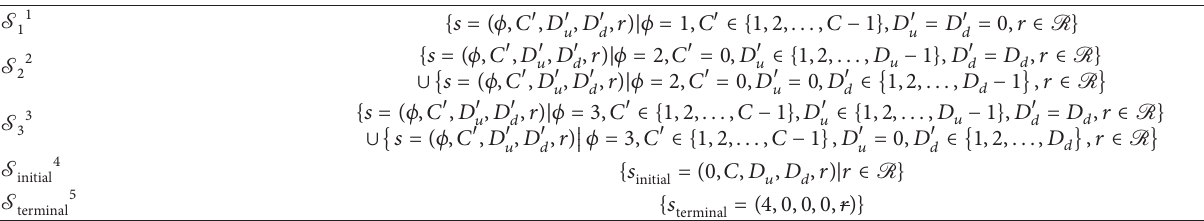
Table 1: Subspaces of the state